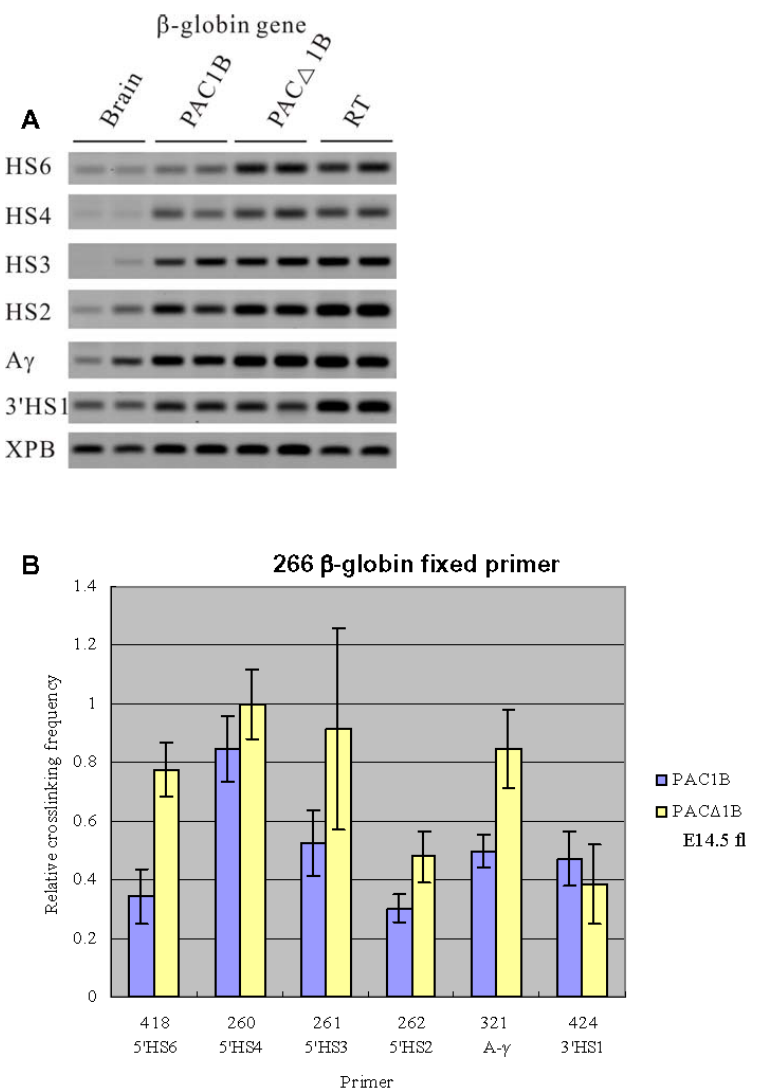
Figure 3. 3C analysis of the PAC1B and PAC D 1B transgenic lines using a primer from the human b -globin gene in combination with primers from other parts of the locus. Fetal livers were collected from E14.5 embryos for this set of 3C experiments. (A) Representative examples of the PCR fragments resulting from the 3C experiments. (B) Histogram of the relative crosslinking efficiencies after quantitation and normalization. The histograms are the average of at least three separate experiments, with each PCR performed in triplicate.